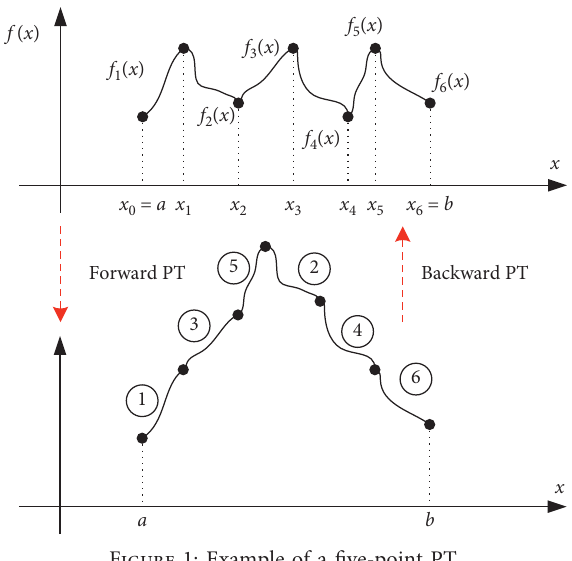
Figure 1: Example of a five-point